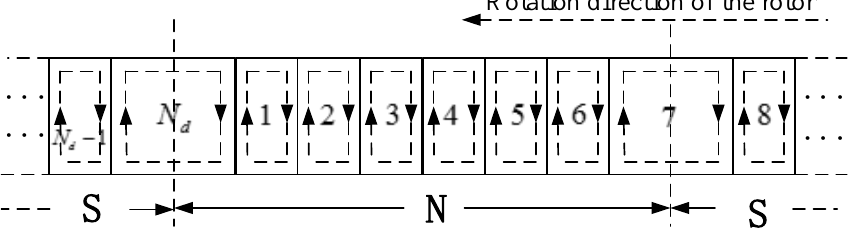
Figure 3. Damping loop structure diagram.